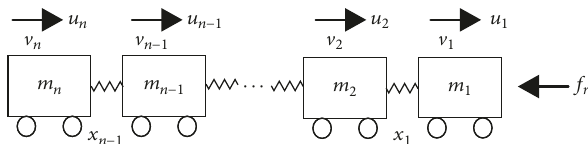
Figure 1: The multiple mass-point model structure of high-speed